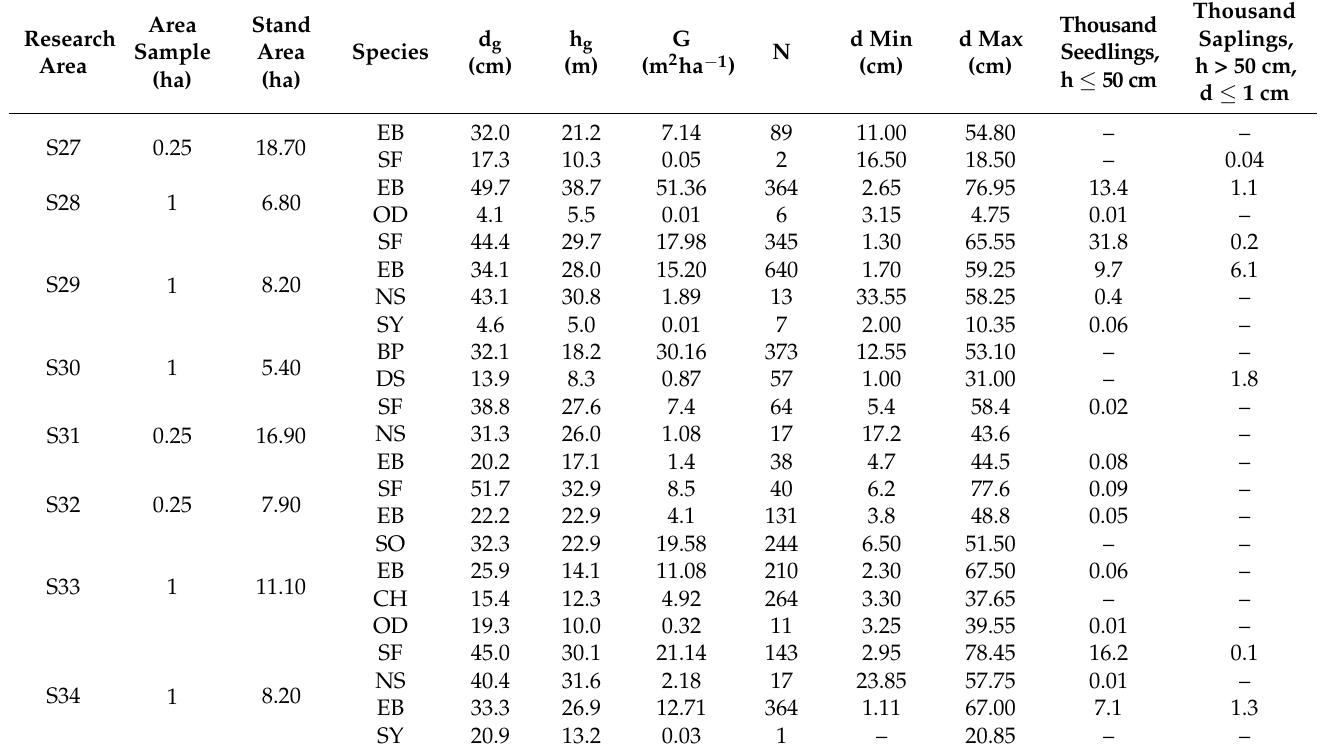
Table 2. Characteristics of the stand structures in the key